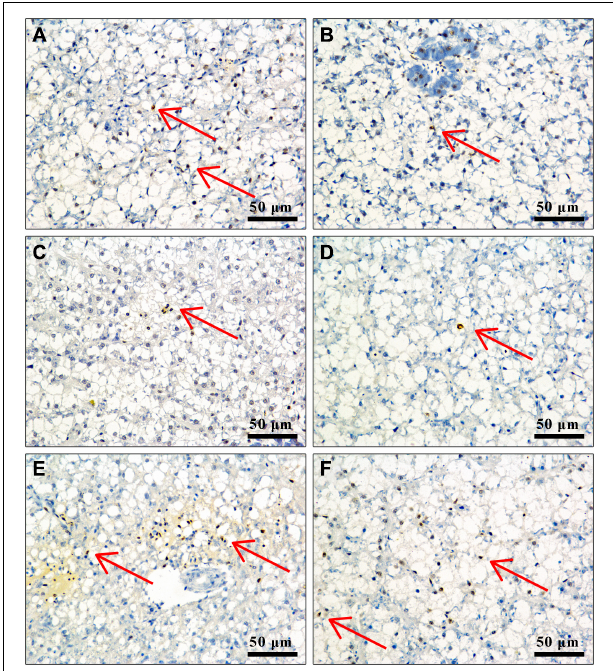
FIGURE 5 | Liver cell apoptosis of GIFT infected with S. iniae after being fed different APS levels. (A–F) Represent the control, 0.5, 1, 2, 4, and 8 supplementation treatments, respectively. The red arrow indicates apoptotic